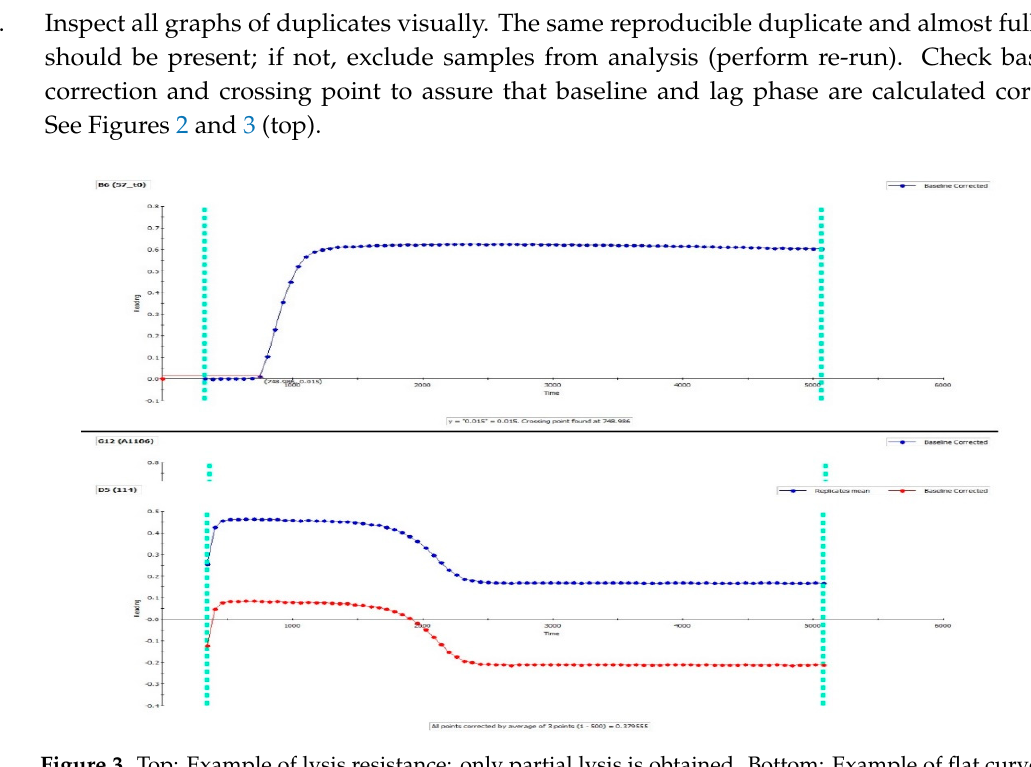
Figure 3. Top: Example of lysis resistance: only partial lysis is obtained. Bottom: Example of flat curve showing no net fibrin formation. Note the baseline